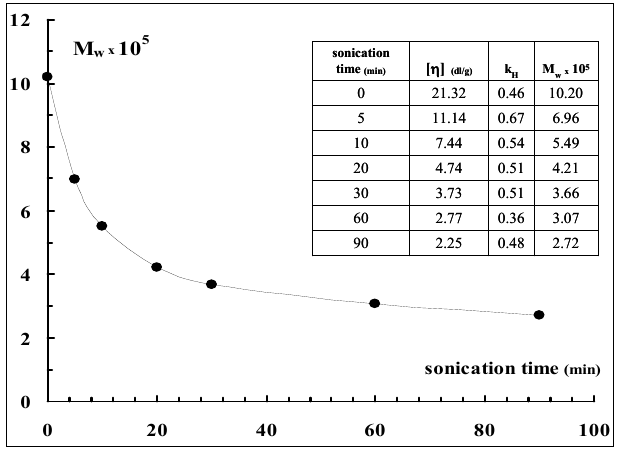
Figure 7. Sclg molecular weight dependence on sonication time (NaOH = 0.01 N, T = 25 °C), together with the calculated Huggins constants (k